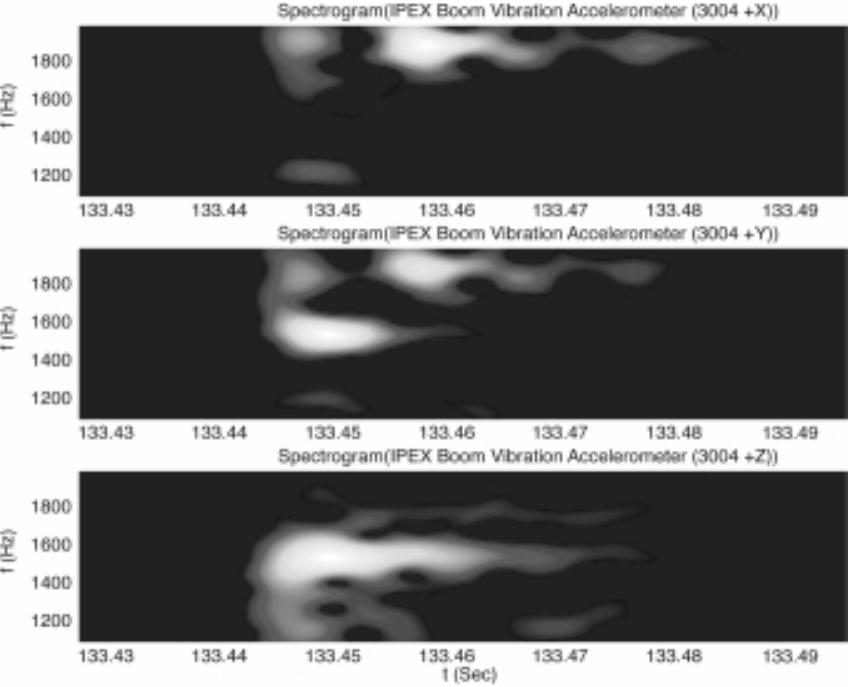
Fig. A2. Event 1 Node 3004 Spectrogram.